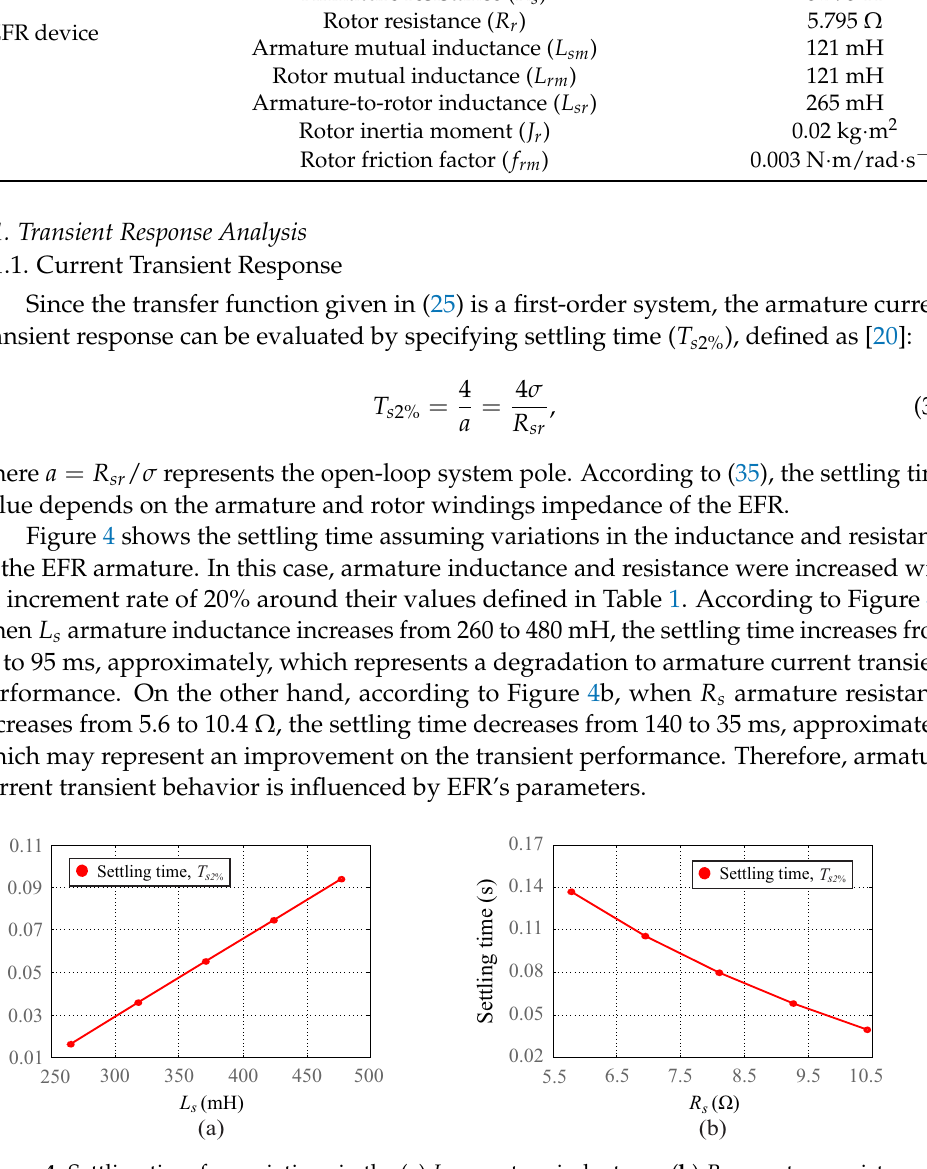
Figure 4. Settling time for variations in the ( a ) L s armature inductance ( b ) R s armature